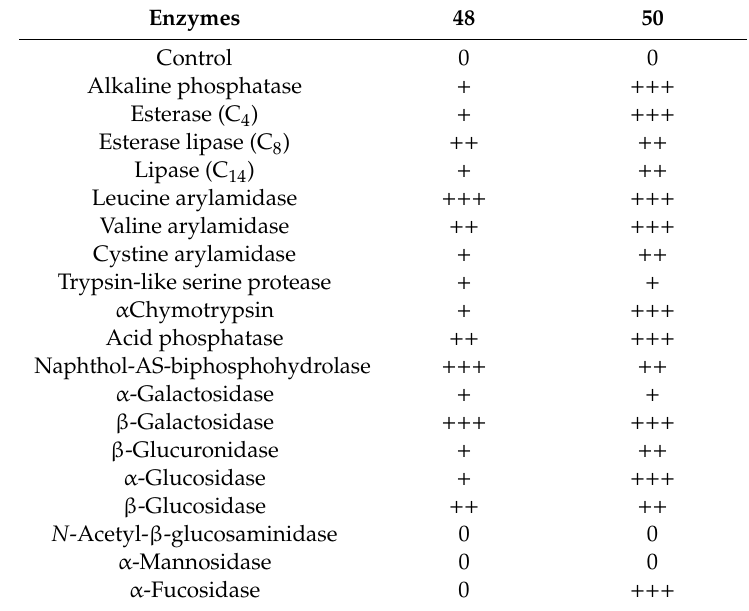
Table 4. Extracellular enzymes productions from TC48 and TC50 in vitro.